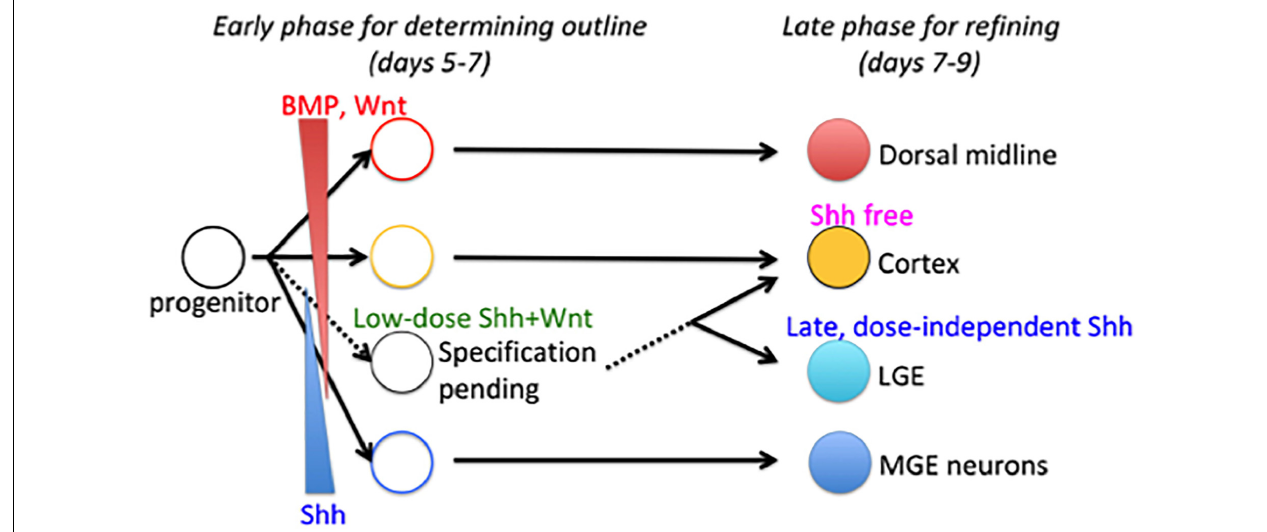
FIGURE 8 | Two-phase specification model for telencephalon patterning. Fate of dorsal midline telencephalic cells is determined by BMP/WNT signaling, whereas the fate of ventral-most telencephalon (MGE) cells is determined by a high dose of Shh signal during the early phase (shown by solid lines). Fate determination of intermediate subregions is conditional (shown by dashed lines). LGE is specified by a dose-independent Shh signal during the late phase through a temporal shift in progenitor states for the Shh